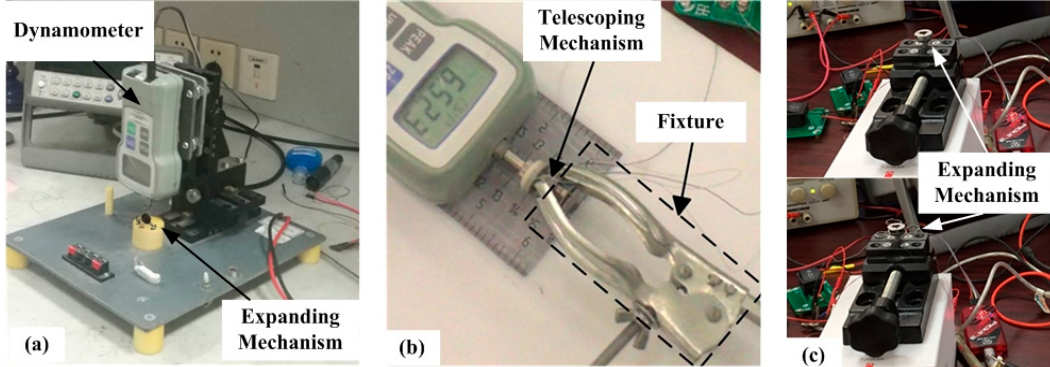
Figure 10. Bench tests: ( a ) Expanding force test, ( b ) axial thrust test, and ( c ) work time test of the expanding mechanism.